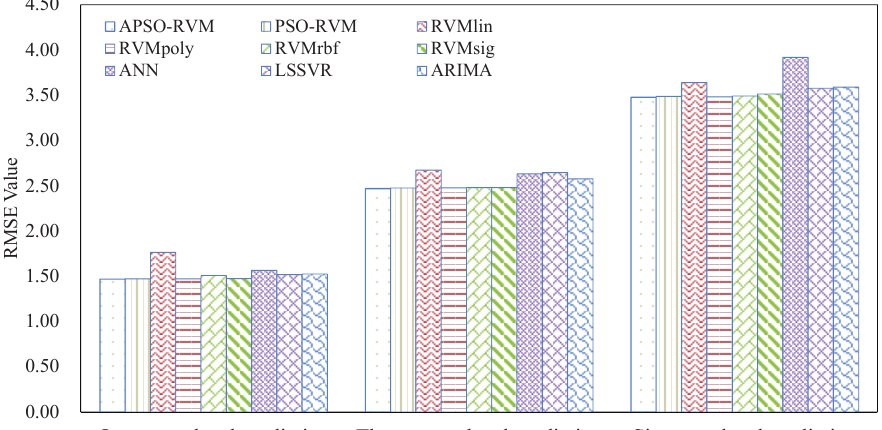
Figure 3. Mean absolute percentage error (MAPE) by different single methods.